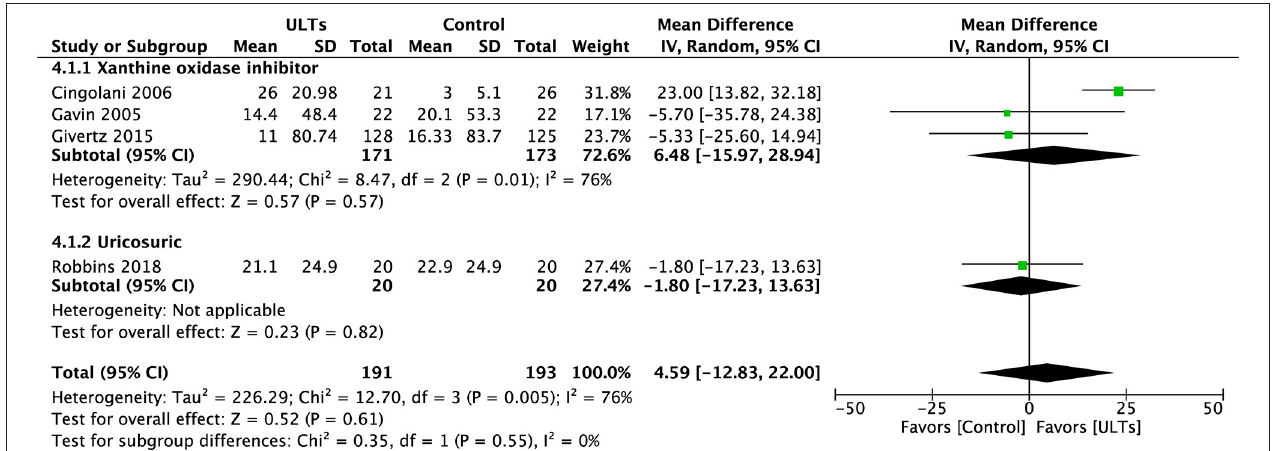
FIGURE 7 | Meta-analysis of 6-Min Walk Test.